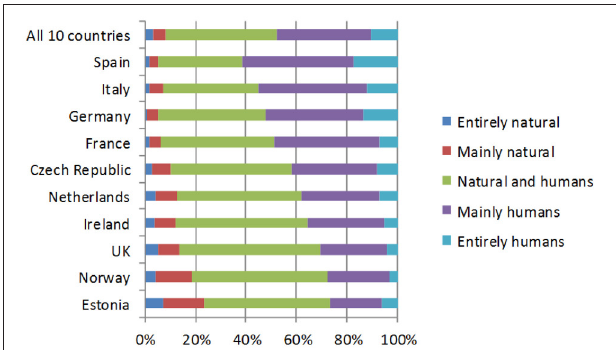
FIGURE 2 | Responses to the question “Thinking about the causes of climate change, which, if any, of the following best describes your opinion?” Shown as the percentage of responses (10,106 in total, ca. 1,000 per country) for causes which were: entirely natural, mainly natural, natural and human, mainly human, or entirely human. For all individual countries and all countries